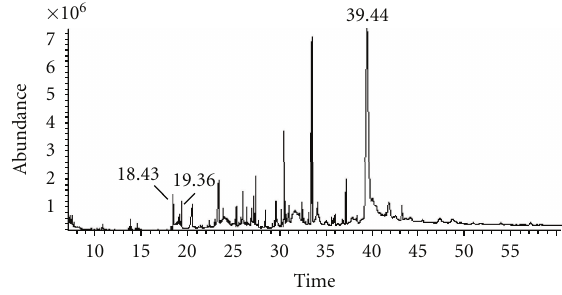
Figure 2: Chromatogram of the total ion current (TIC) obtained by GC/MS analysis of the crude Balanite extract. The x -axis of each GC/MS chromatogram represents the minutes of retention. The chromatogram shows the detected substances with retention times of 2,6-di- tert -butyl-phenol (18.43min), 2,4-di- tert -butyl- phenol (19.36min), and 6-phenyl-2(H)-1,2,4-triazin-5-one oxime